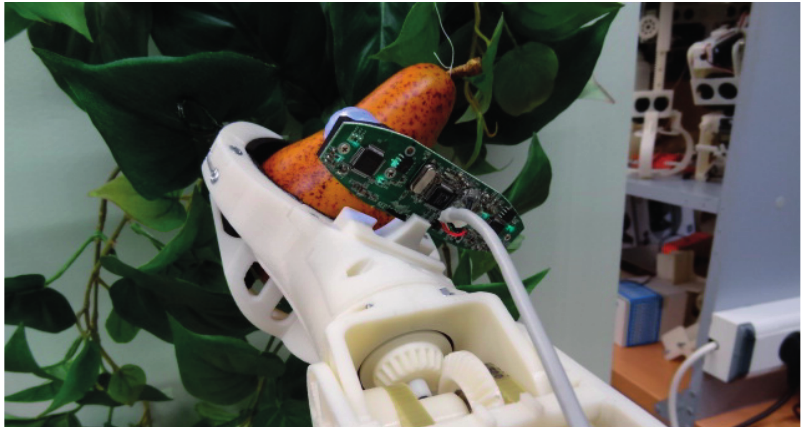
Figure 15. Example of fruit pickup in laboratory